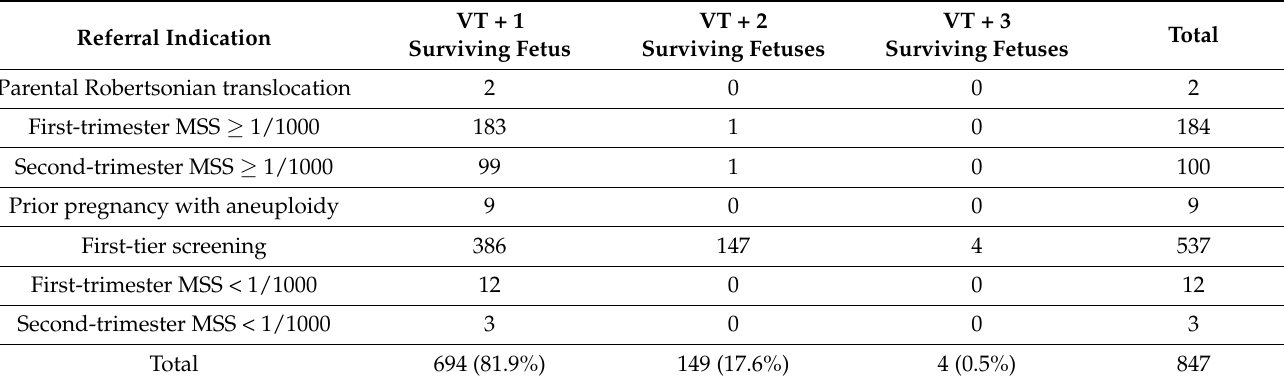
Table 1. Referral indications for study patients ( n =